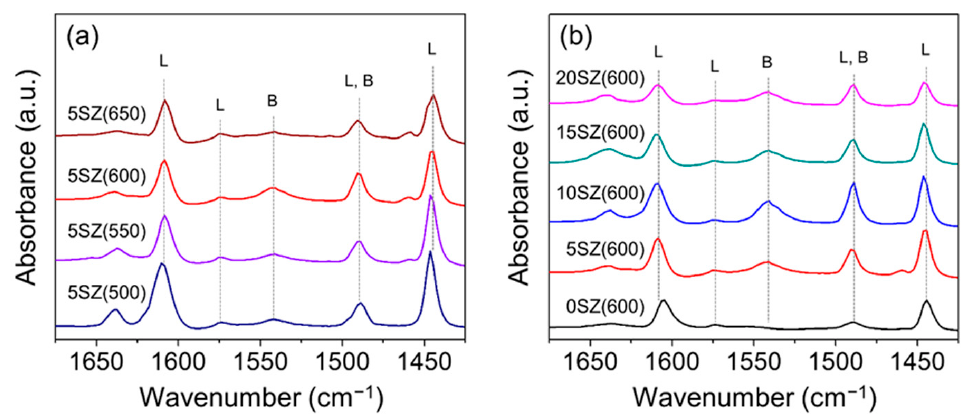
Figure 5. Py-IR spectra of ( a ) 5SZ( y ) and ( b ) x SZ(600) catalysts prepared by using different calcination temperatures and the sulfate contents, respectively.